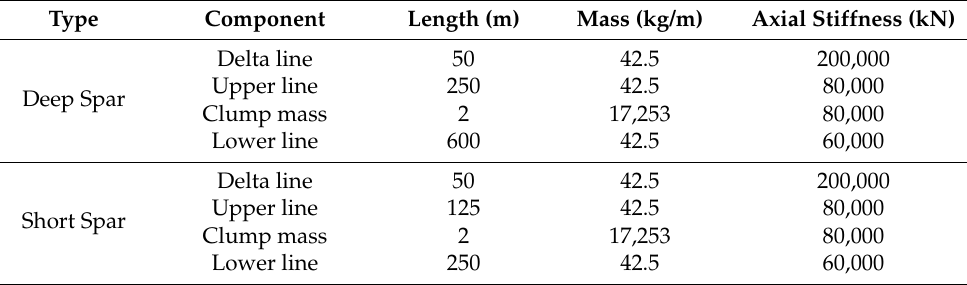
Table 3. The properties of mooring system components.